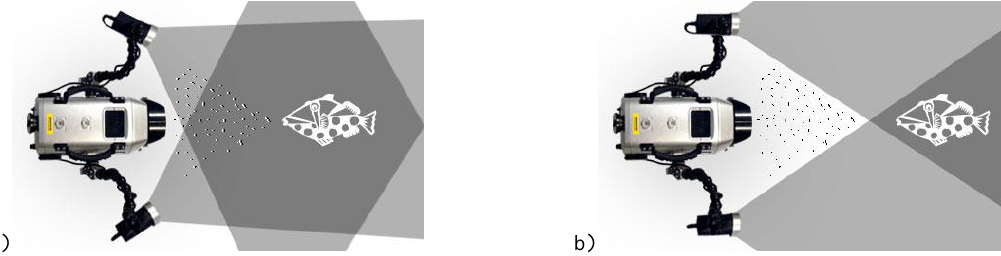
Figure 4. Backscattering: improper (a) and proper (b) position of strobe lights